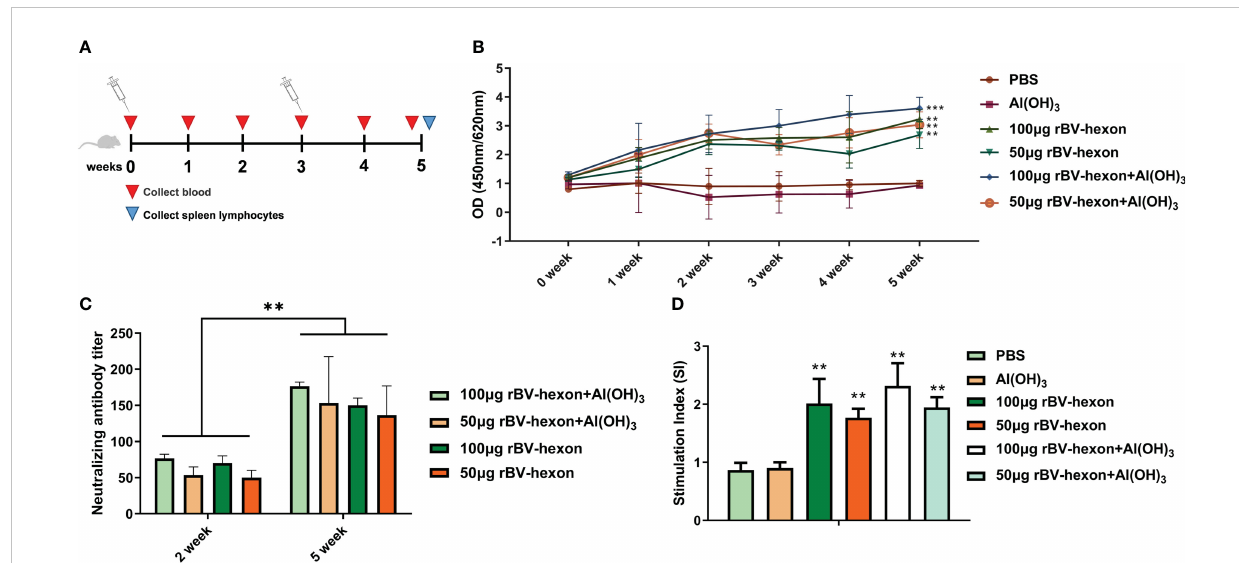
FIGURE 4 rBV-hexon increases speci fi c and neutralizing antibody levels in vivo . (A) Mice (Balb/c, n=6) were immunized with 50 m g rBV-hexon+Al(OH) 3 , 100 m g rBV-hexon+Al(OH) 3 , 50 m g rBV-hexon or 100 m g rBV-hexon, and PBS was used as the negative control. (B) Blood samples were collected weekly and speci fi c antibody titers were measured. (C) Detection of neutralizing antibody titers in the second week after primary and booster immunizations. (D) Lymphocyte proliferation was analyzed after the isolation of mouse spleen lymphocytes. The experiments were repeated over three independent experiments. Error bars represent standard deviation (SD). ** P < 0.01, *** P <